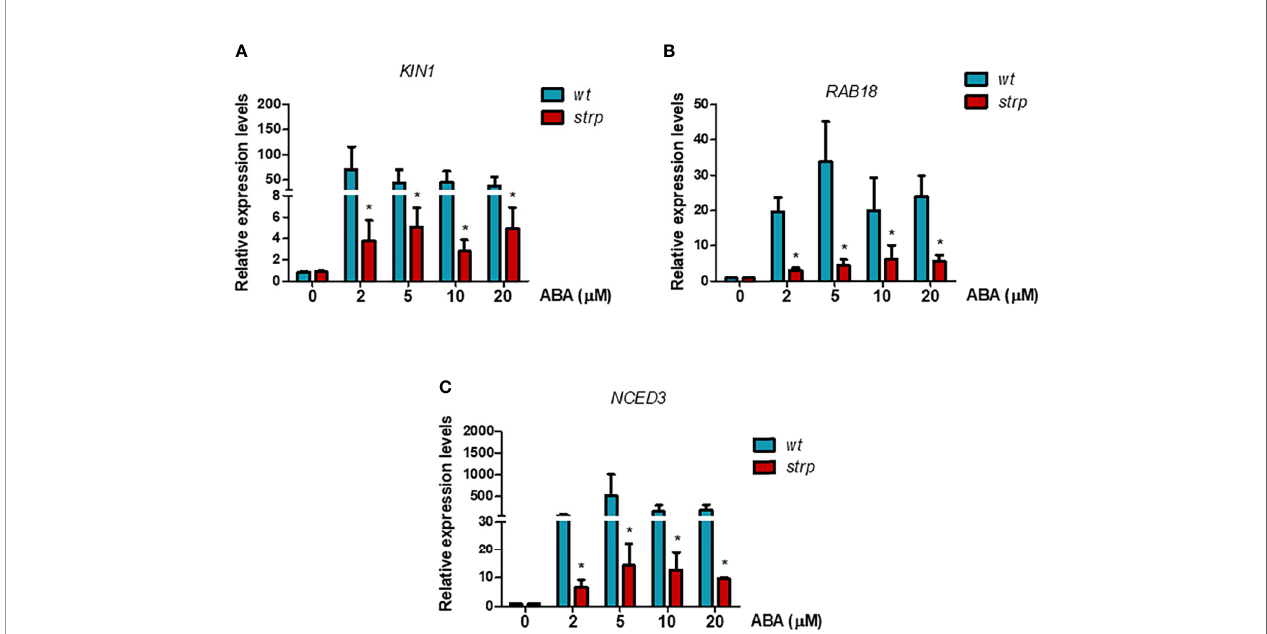
FIGURE 10 | ABA-responsive genes expression is reduced in the strp mutant. Relative expression of KIN1 (A) , RAB18 (B) , and NCED3 (C) was determined on two-week-old wild type and strp plants treated with 2, 5, 10, and 20 µM ABA for 18 h. mRNA levels were normalized to actin mRNA ( ACT8 ). Error bars are S.E.M. of three independent experiments. *P < 0.01, by Student ’ s